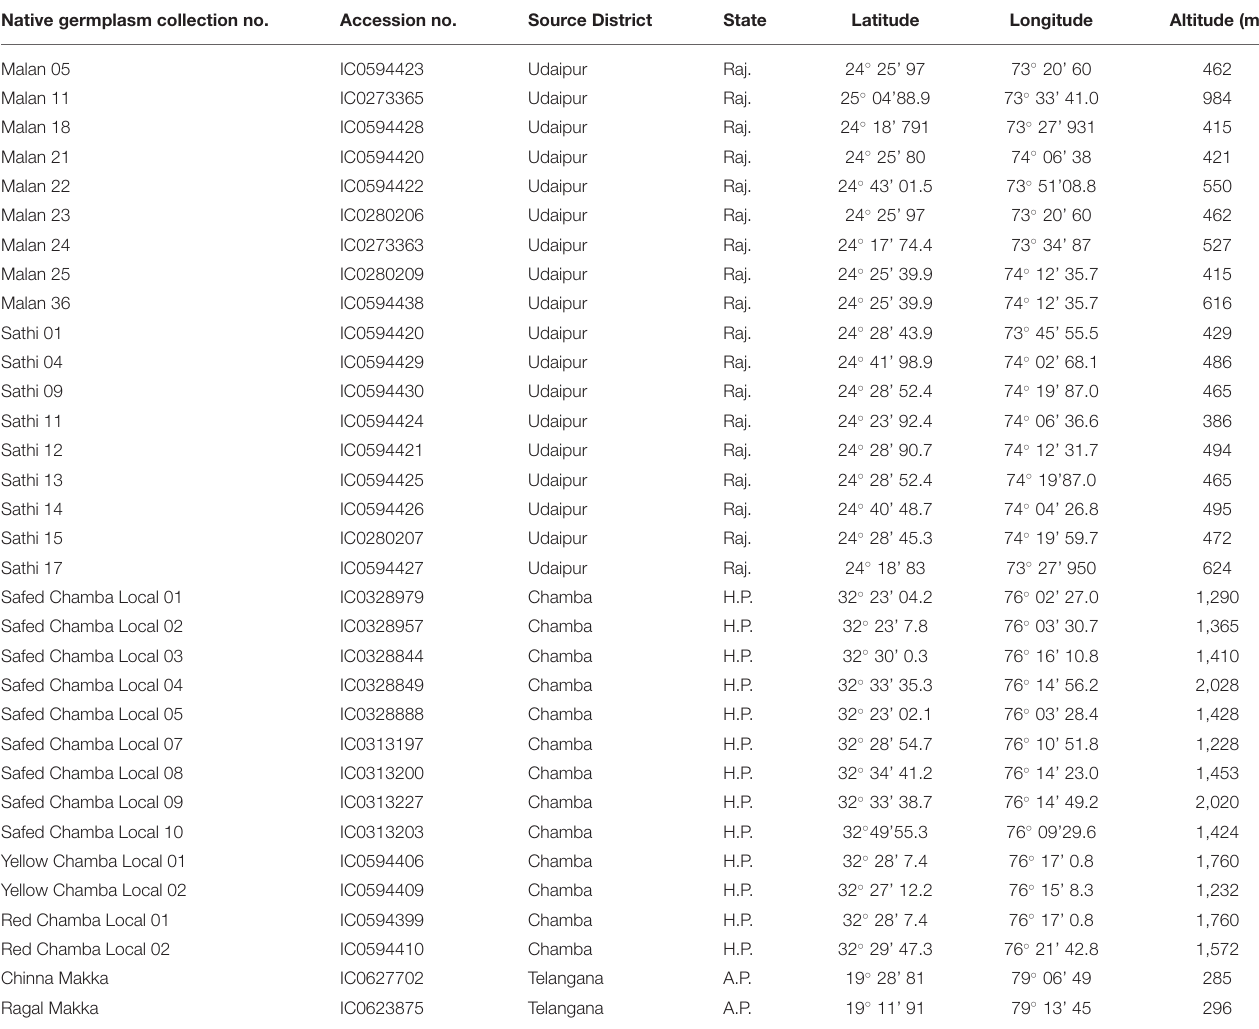
TABLE 1 | Locational details of 33 maize germplasm used in study. Native germplasm collection